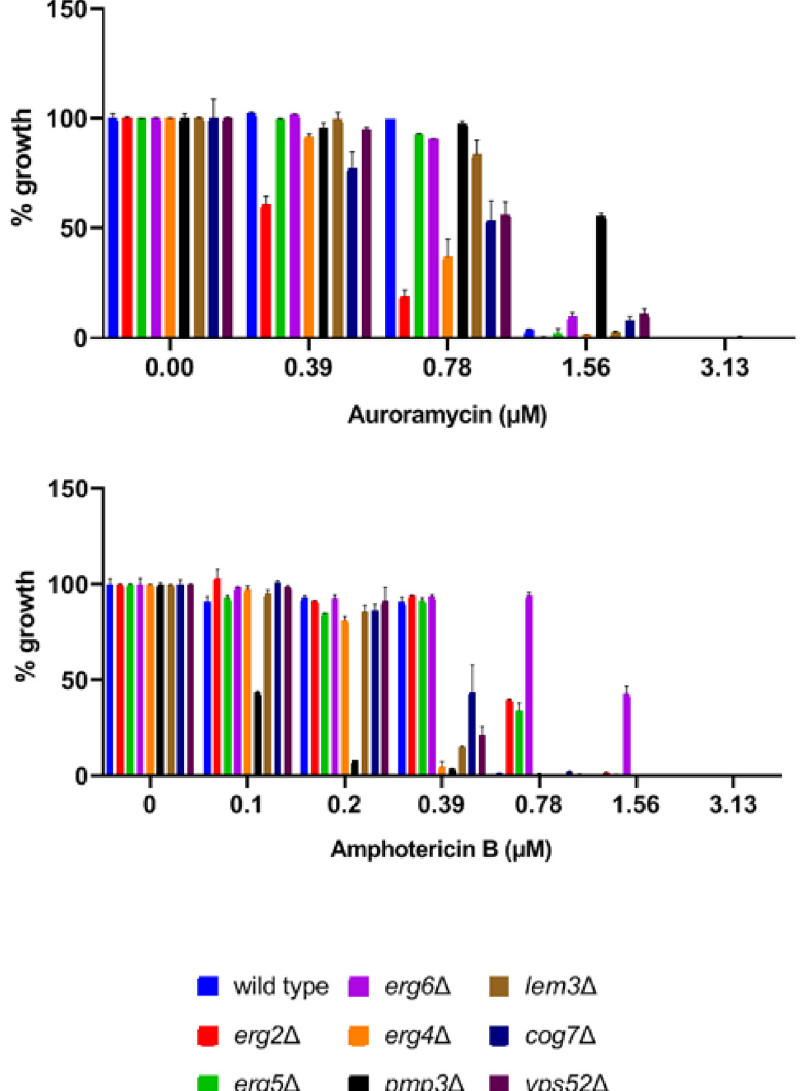
Fig 5. Comparison of sensitivity of mutant strains to auroramycin and amphotericin B. Growth of wild type strain BY4743 and 8 deletion strains in auroramycin or amphotericin B at the indicated concentrations in duplicate. Normalized growth after 24 hours of incubation at 30 ˚C is plotted for each strain. Error bars (n = 2 Mean ± S.D) are indicated in the plots.